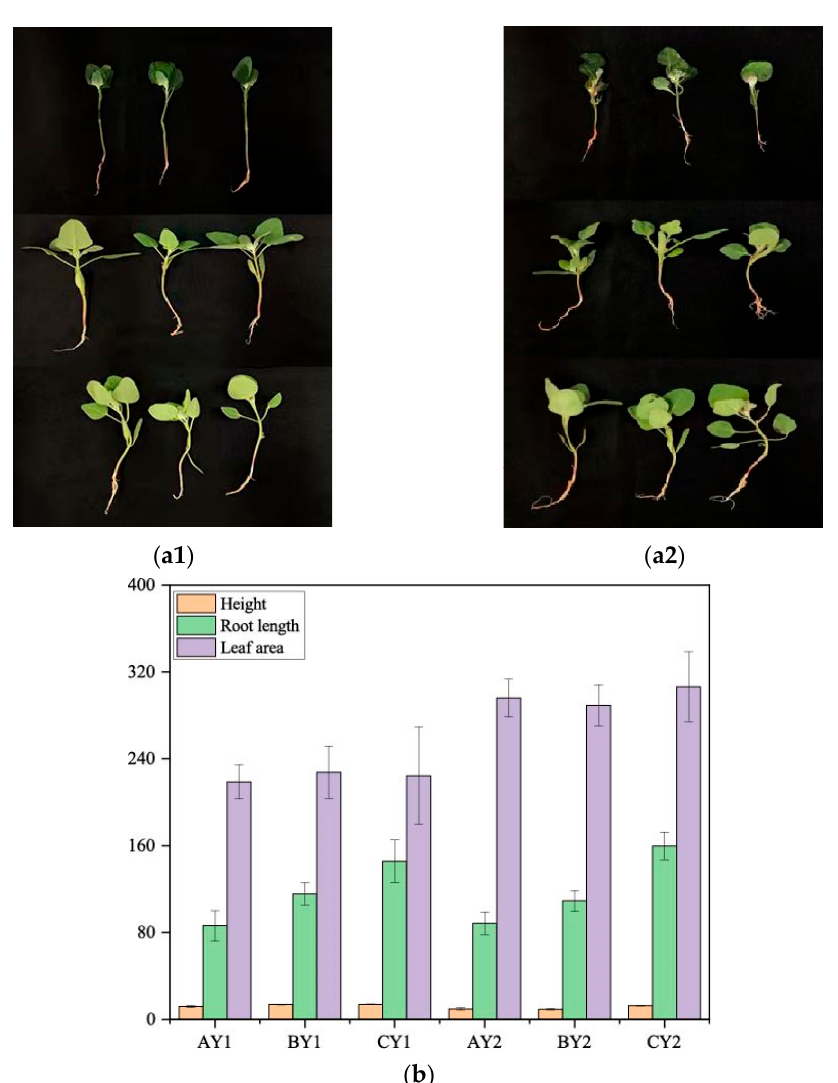
Figure 1. Phenotypic map of quinoa under different treatments: ( a1 ) Dian Quinoa 2324 ( a2 ) Dian Quinoa 281. from top to bottom, AY1, BY1, CY1 vs. AY2, BY2, CY2 treatments. ( b ) Height (cm), root length (mm), leaf area (mm 2 ). Error bars indicate SEs.